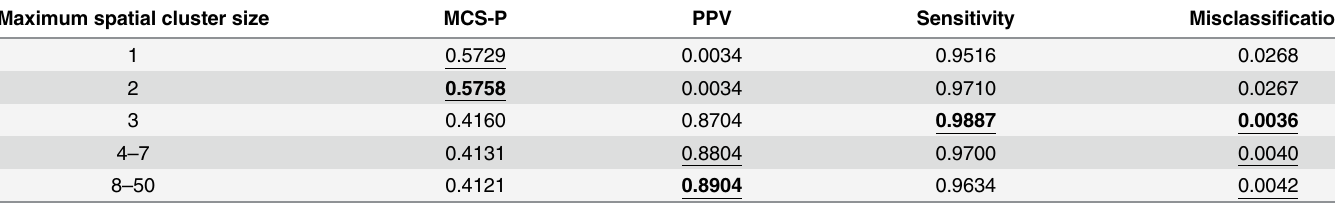
Table 4. Average performance measures for different maximum spatial cluster sizes in